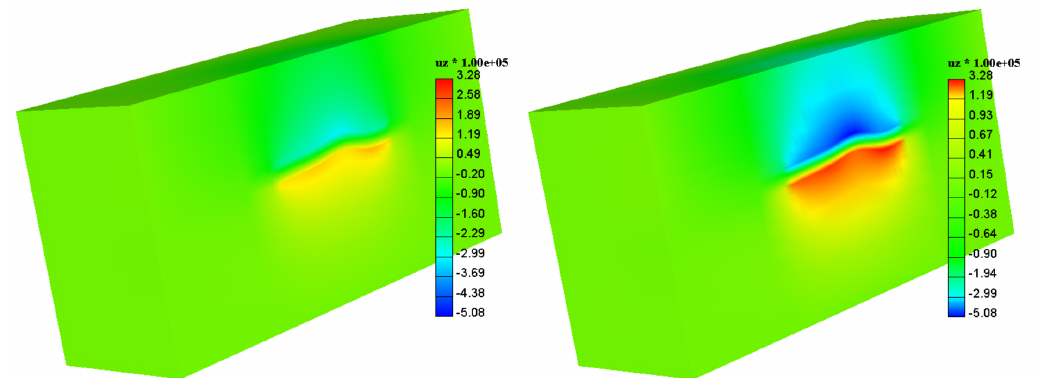
Figure 31. u z snapshots at 20 and 40 years of evolution for conforming case.